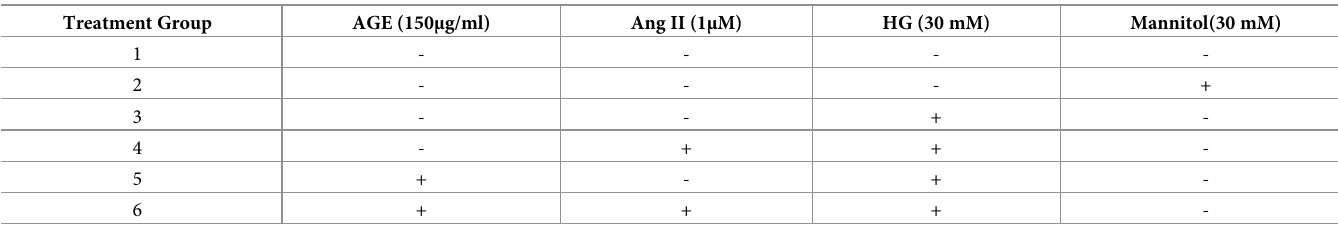
Table 1. Treatment strategy for optimization of in vitro DN